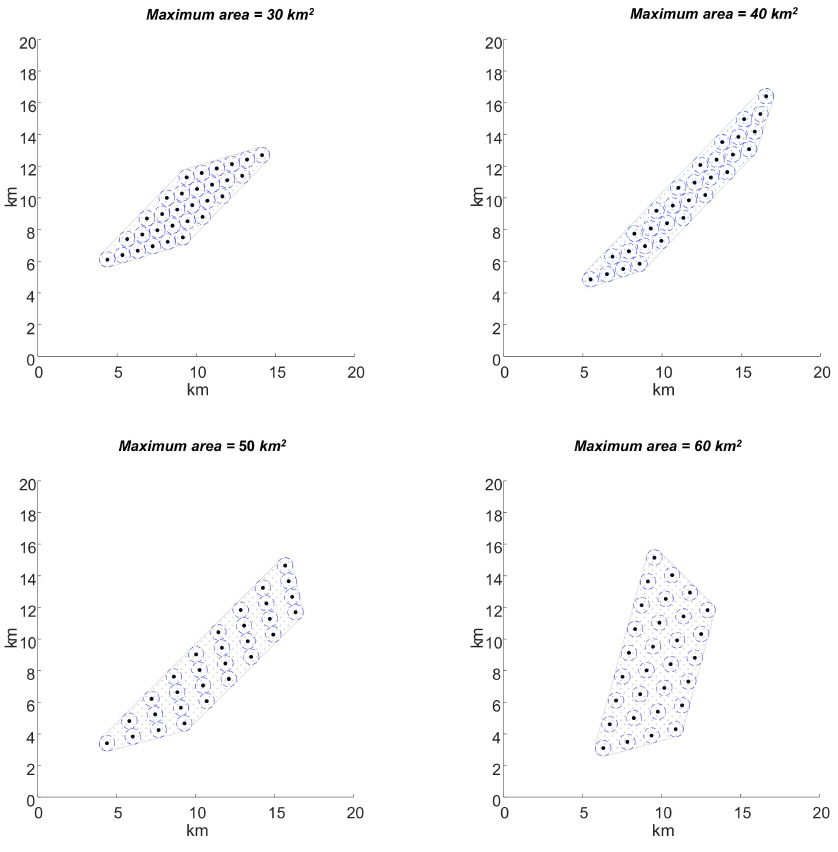
Figure 9. Optimal layouts obtained in Case 2 for R w = 3 D depending on the maximum allowed area. The dotted surface represents the area occupied by the wind